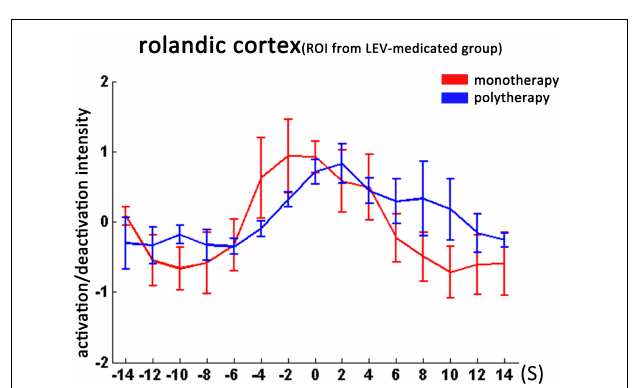
FIGURE 4 | Temporal features of dynamic activation/deactivation associated with CTS in the Rolandic cortex in the monotherapy and polytherapy LEV-medicated patients. Activation/deactivation changes during CTS from ROI of left Rolandic cortex (ROI from LEV-medicated group). Mean value and standard error of activation/deactivation intensity time course in monotherapy LEV-medicated patients and polytherapy LEV-medicated patients visualize with red and blue lines, respectively. There was no significant intensity difference between the two